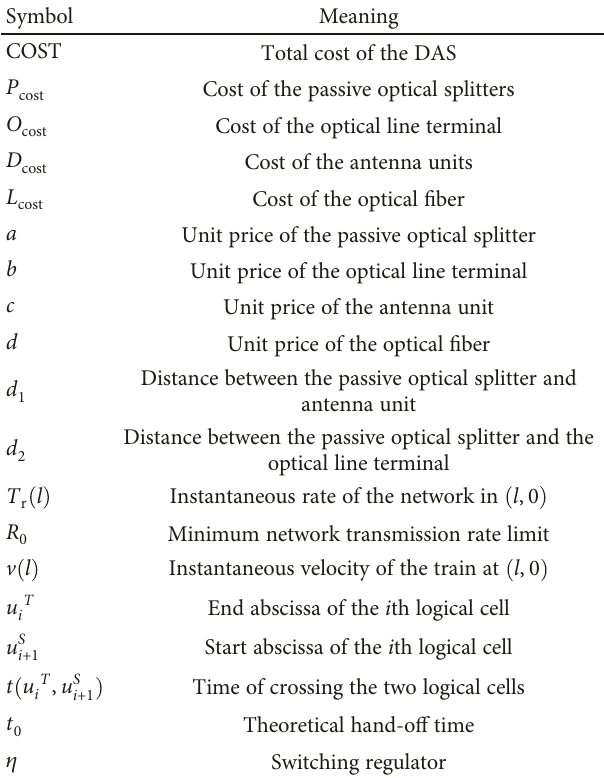
Table 2: Introductions of the parameters used in Section 3.